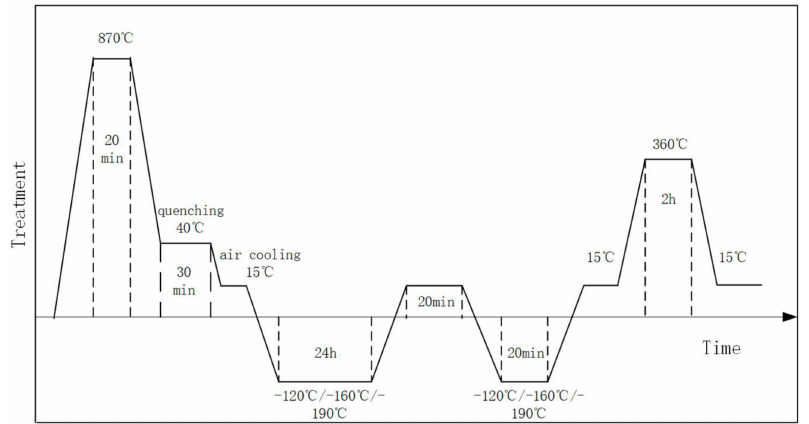
Figure 1. A schematic of process schedules applied for 42CrMo alloy